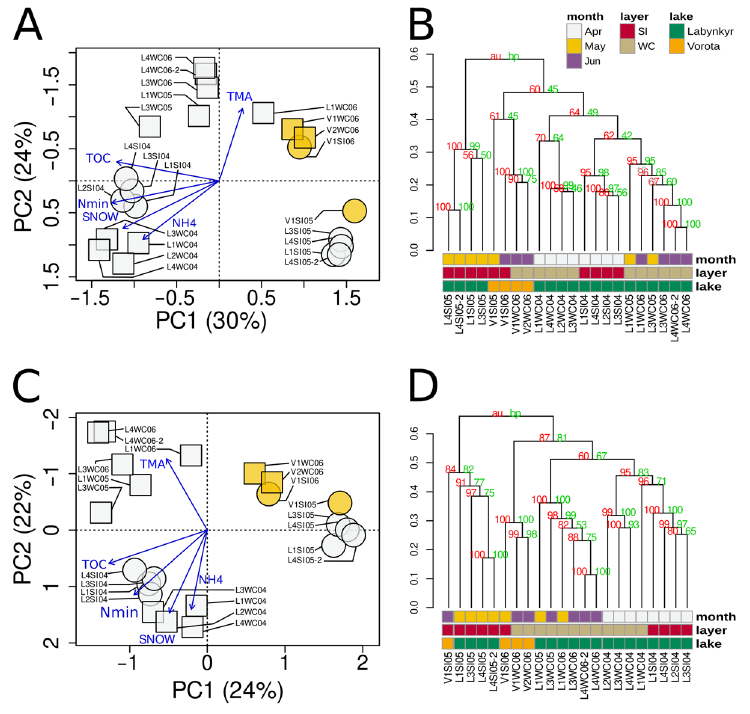
Figure 3. Exploratory analysis of LL and LV microeukaryotic community profiles. Upper and bottom rows of the image were generated using different minimum OTU abundance thresholds: OTU relative abundance ≥ 0.1% (“major OTUs”) ( A , B ) and OTU standardized total abundance ≥ 50 ( C , D ). The former OTU count matrix contains 95 top-abundant OTUs with minimum OTU standardized total abundance ≥ 361. The latter count matrix consists of 253 OTUs. ( A , C ) tb-PCoA ordination biplots. Point shape: SI—circle, WC—square. Point color: LL—grey, LV—yellow. Blue arrows—linear regression of explanatory variables, showing the direction and range of their impact. ( B , D ) UPGMA-assisted community profile clustering dendrograms based on Bray–Curtis pairwise distance matrices. Red and green numbers indicate the “approximately unbiased” p -values and “bootstrap probability” values, respectively. Color annotation above the sample IDs encodes the spatial and temporal sampling parameters.